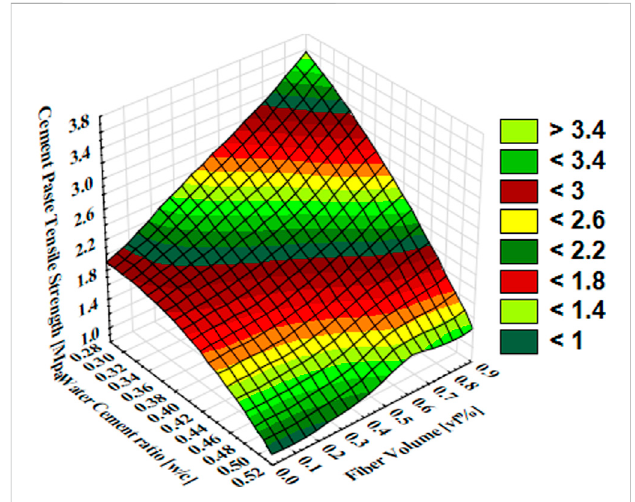
FIGURE 5 Cement-paste tensile strength (MPa) against the fi bre-volume fraction, V f (%) and water-cement (w/c)